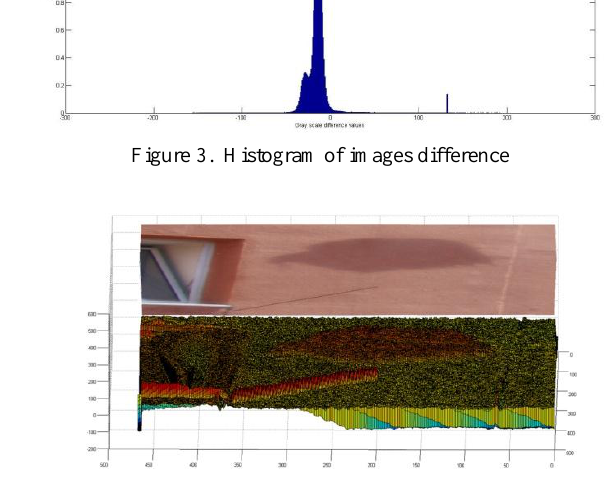
Figure 4. 3D view of images difference